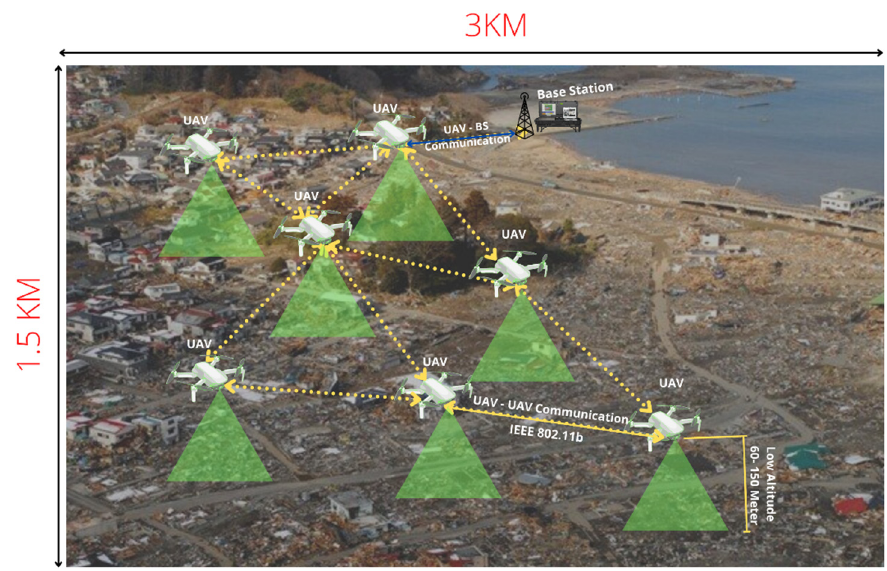
Figure 4. UAV ad hoc network in search and rescue scenario.